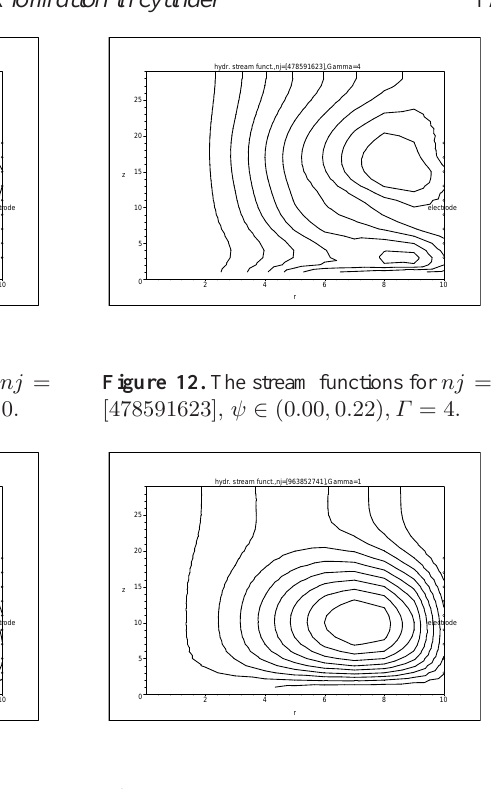
Figure 14. The stream functions for nj = [963852741] , ψ ∈ ( − 0 . 43 , 0 . 17) , Γ = 1 .